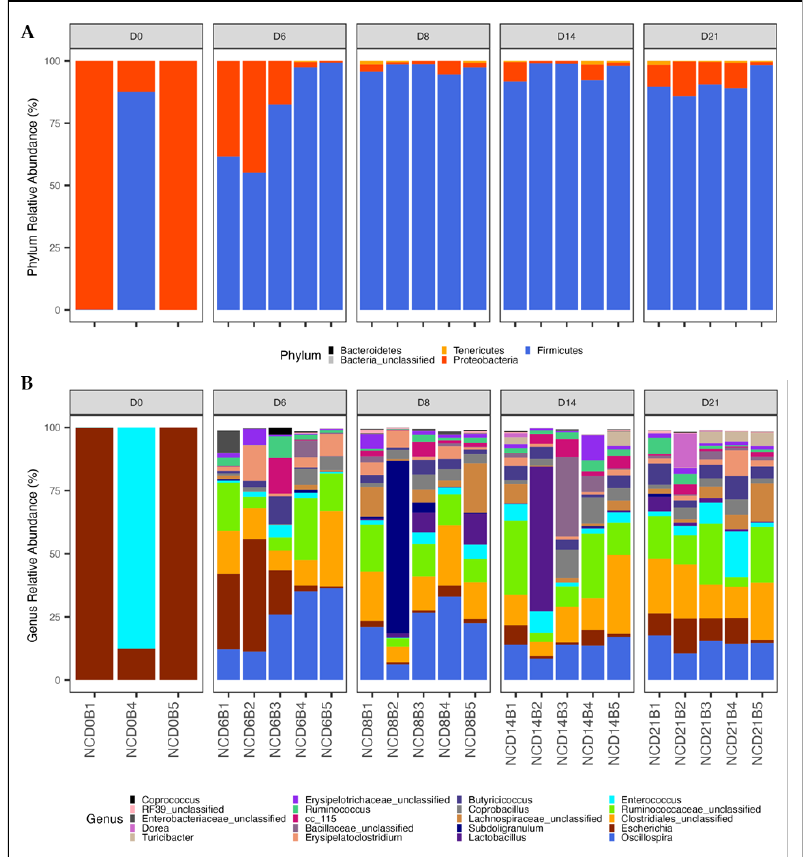
Figure 2. Variation in bacterial composition with age. Bacterial composition was visualized by calculating the relative abundance of CSS normalized data at the phylum ( A ) and genus ( B ) levels using 3 to 5 birds per age. Only the top 20 genera are shown.